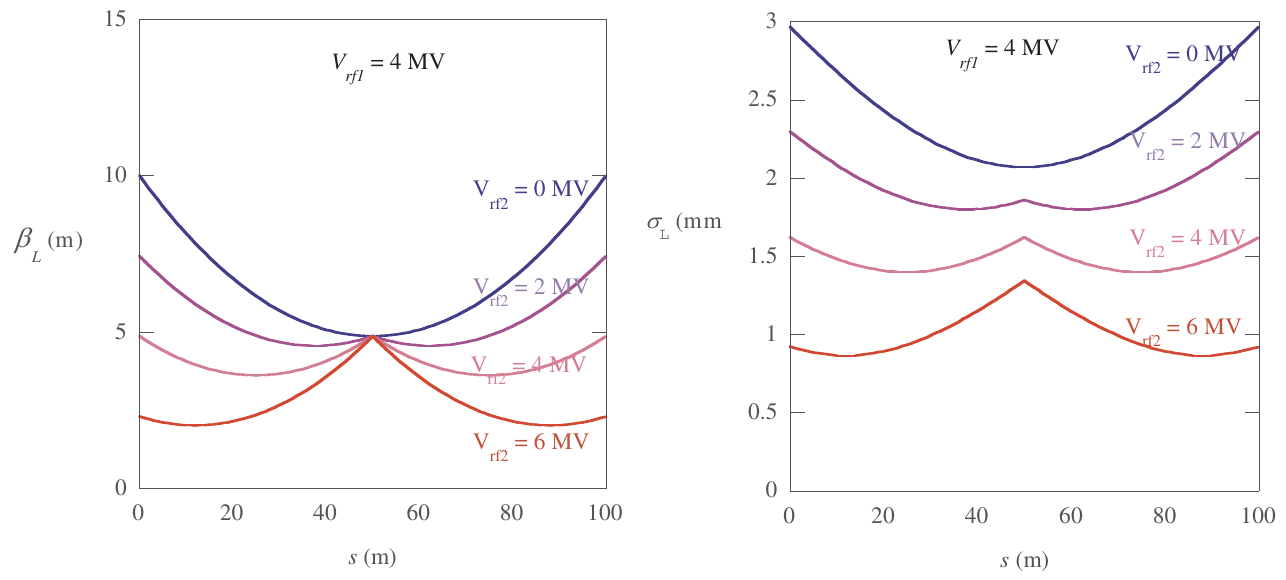
(cid:3) s (cid:4) with two cavities placed in 1